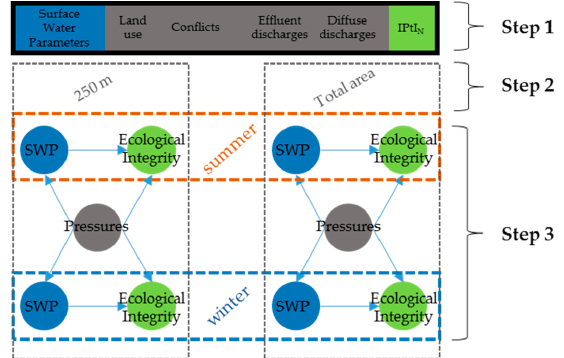
Figure 2. Methodological workflow. Pressures refer to land uses and environmental land use conflicts as well as point source and diffuse effluent discharges. SWP refers to the surface water parameters identified in Table 1. The assessment of ecological integrity was based on the IPtI N index.